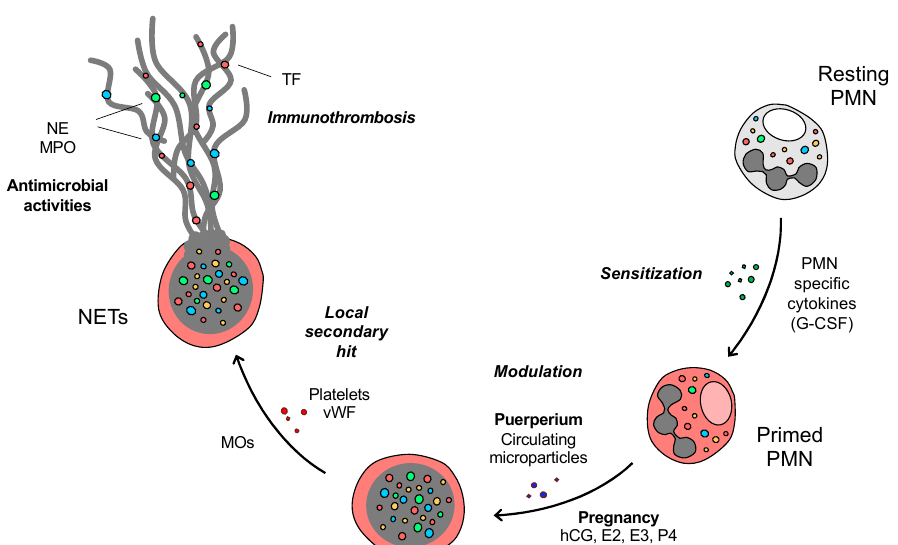
Figure 7. Proposed model of the mechanisms by which neutrophils exhibit a pro-NETotic state and enhanced tendency to release NETs early after delivery in response to specific physiologic stimuli promoting thrombosis. G-CSF is a major signal inducing neutrophil release from the bone marrow, providing an important emergency mechanism by which the level of circulating neutrophils and sensitization is increased postpartum. The degree of neutrophil activation seems to be finely tuned by the unique stoichiometry of surrounding sex hormones and microdebris, which are produced by a variety of tissues and cells, including the wounded endothelium and platelets, and reach their peak concentrations shortly after term. Finally, NETs are released locally after this second hit in the vicinity of activated endothelial loci, where polymerized chains of vWF might already deploy under the presence of excessive post-delivery secondary stimuli, thus facilitating the thrombotic